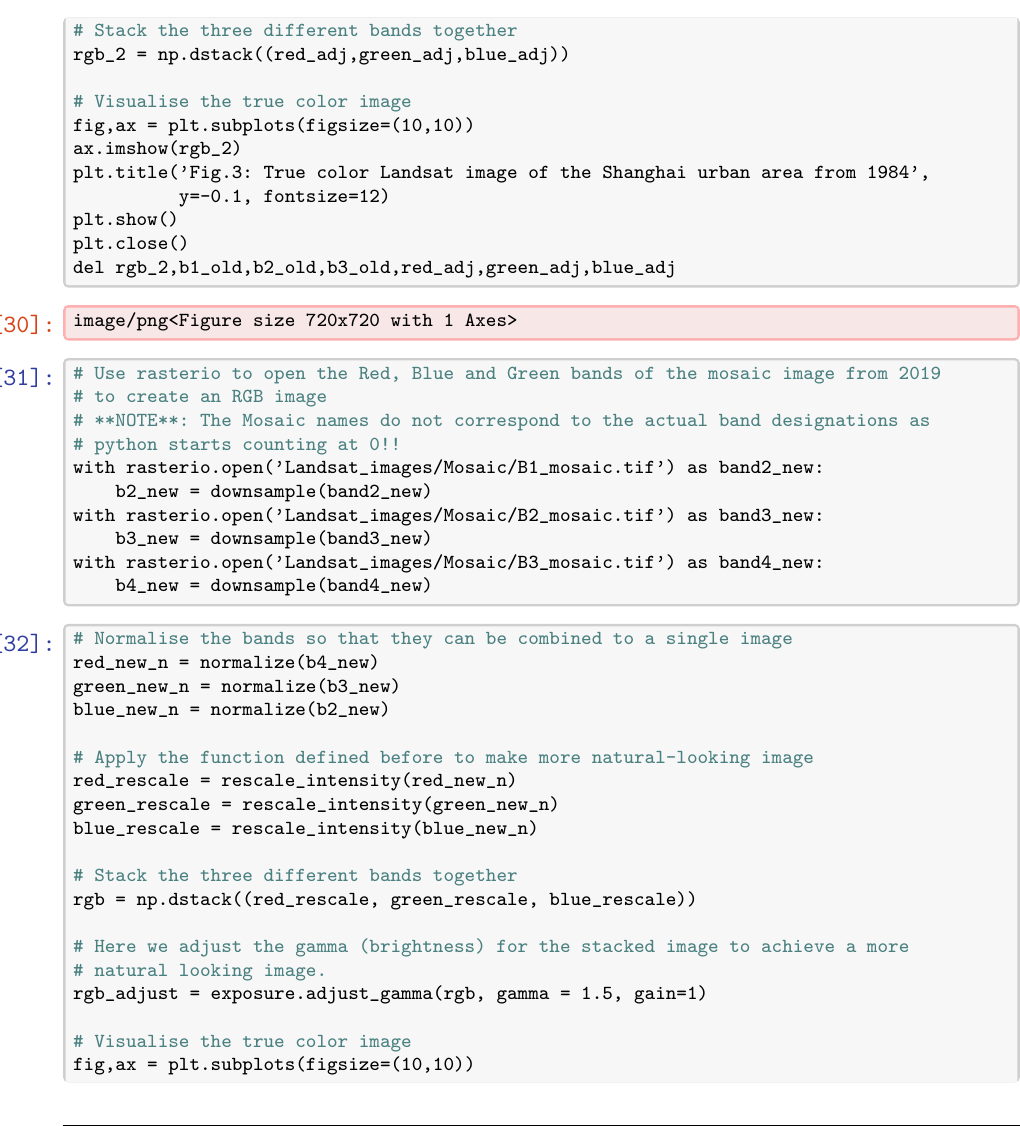
REGION : Volume 7, Number 2,